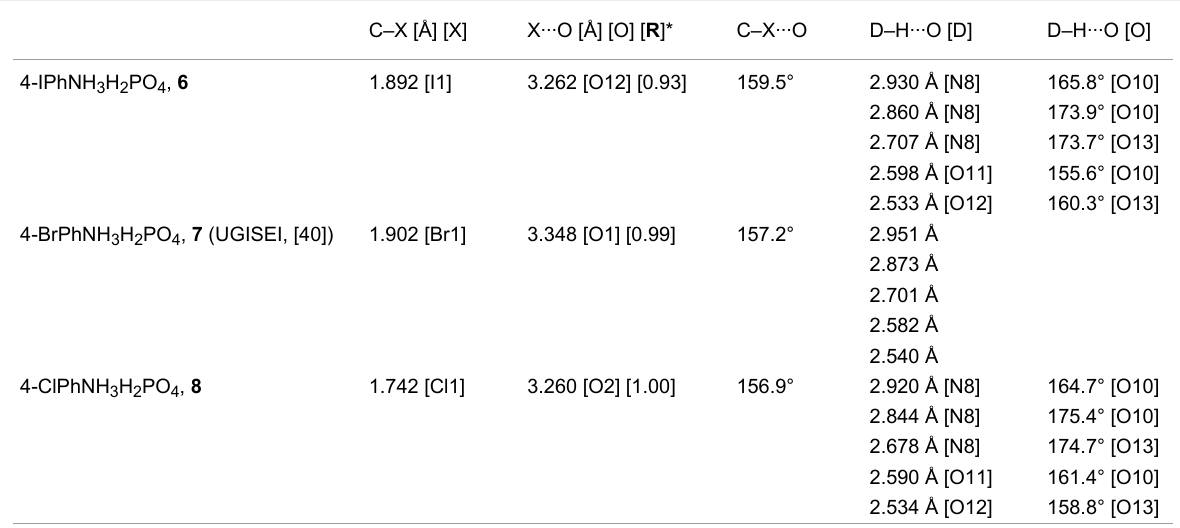
Table 3: Relevant covalent bond, hydrogen bond and halogen bond lengths and angles in 6 – 8